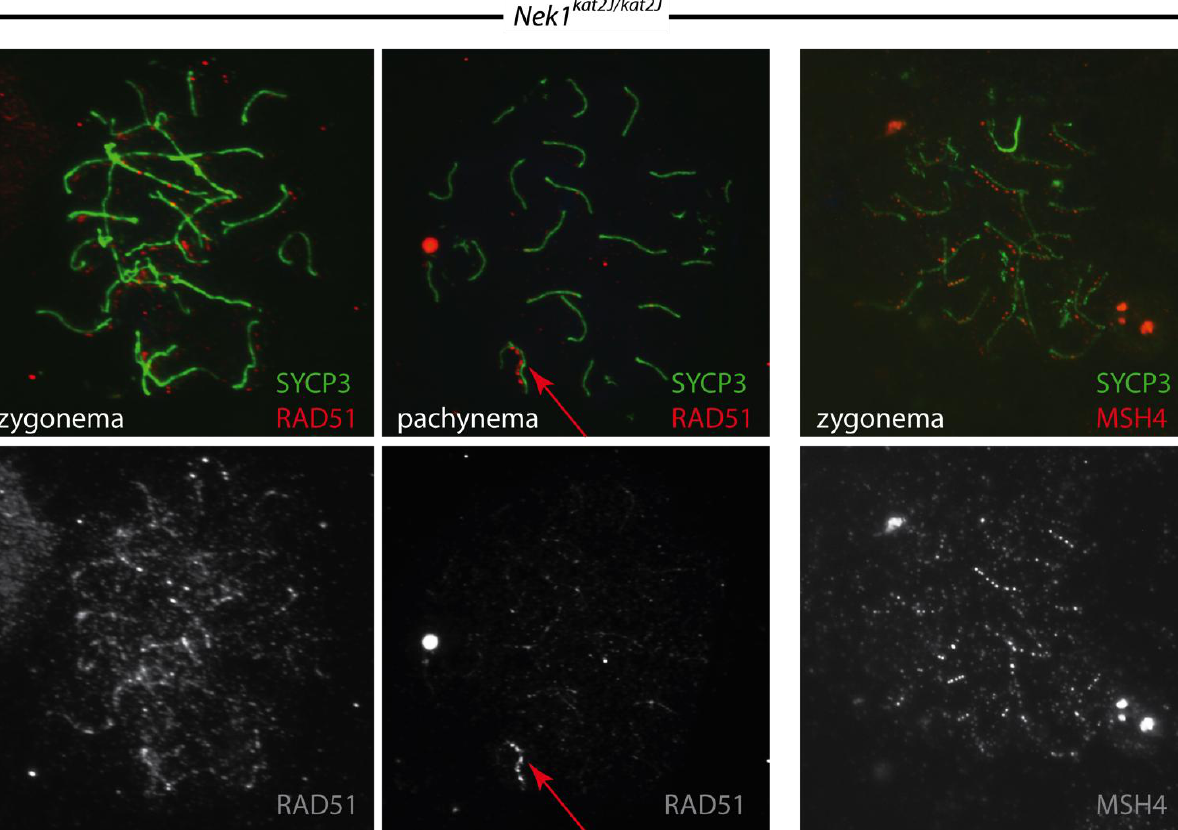
Figure 5. Nek1 kat2J/kat2J spermatocytes undergo normal double-strand break (DSB) initiation and repair. Wild type (not shown) and Nek1 kat2J/kat2J testes were stained with a variety of antibodies against meiotic prophase I proteins. Shown here is staining with SYCP3 (green), and either RAD51 or MHSH4 (red) during the zygotene and pachytene stages of prophase